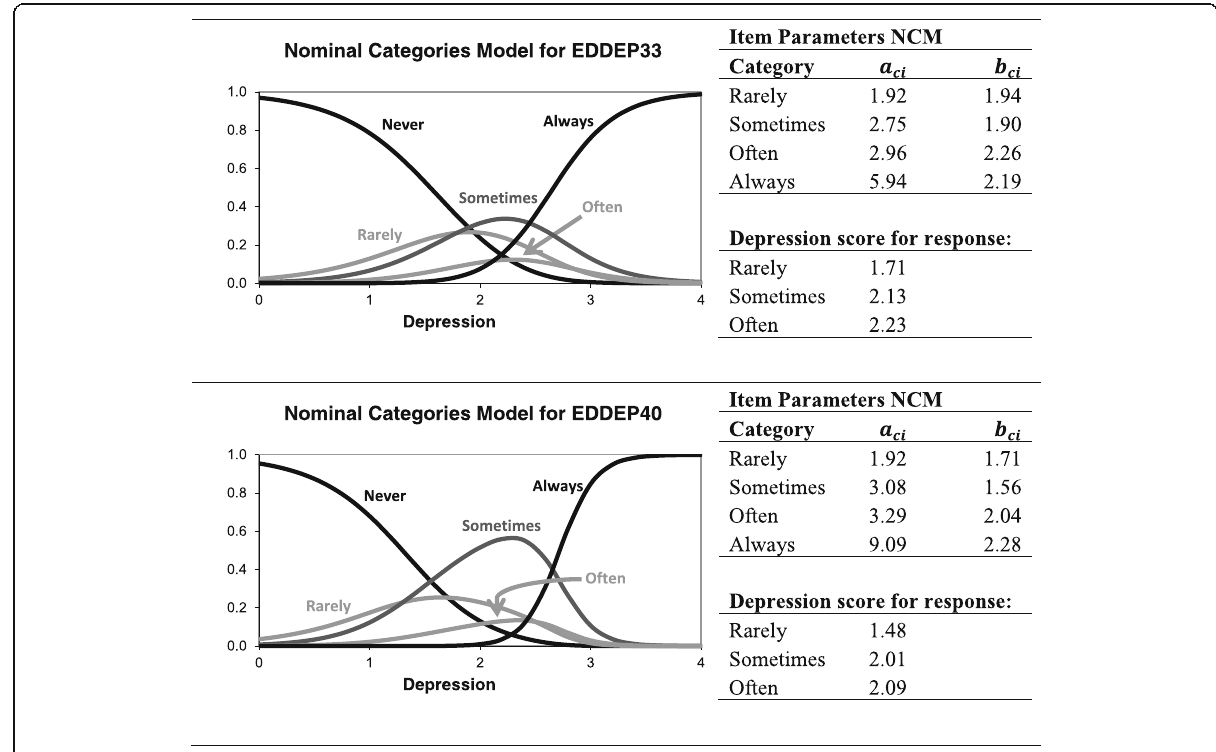
Fig. 8 Evaluation of category order for item EDDEP33 and EDDEP40 using the nominal categories IRT model